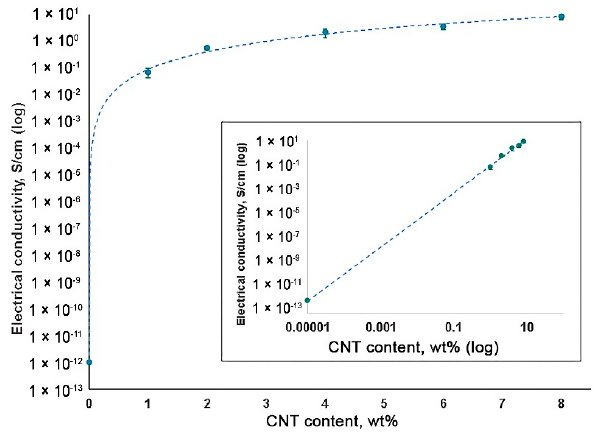
Figure 7. Electrical conductivity of SIBS–CNT films of different nanofiller concentrations.